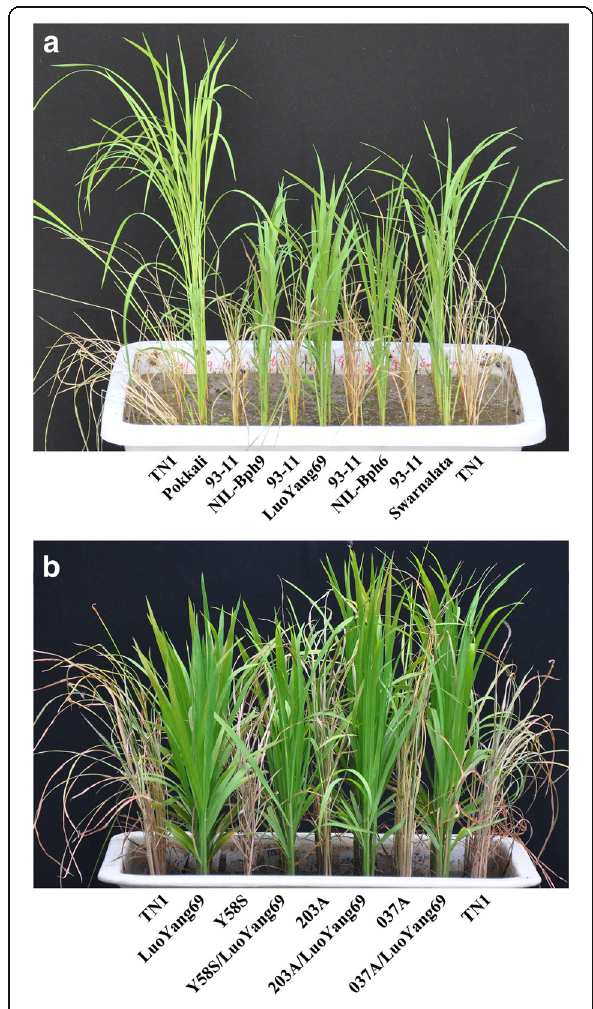
Fig. 2 BPH resistance assay of LuoYang69. a BPH resistance assay of near-isogenic lines and pyramided line. b BPH resistance assay of hybirds and pyramided lines. LuoYang69, Bph6 and Bph9 pyramided line in 93-11 genetic background; Pokkali and Swarnalata are the resistance donors of Bph9 and Bph6 ,respectively; NIL- Bph6 and NIL- Bph9 are the near-isogenic lines harboring Bph6 and Bph9 in 93-11 genetic background, respectively; Y58S, TGMS line; Y58S/LuoYang69, hybrid derived from Y58S and LuoYang69; 037A and 203A, HL type CMS lines; 037A/LuoYang69 and 203A/LuoYang69, hybrids derived from 037A and LuoYang69, 203A and LuoYang69, respectively;